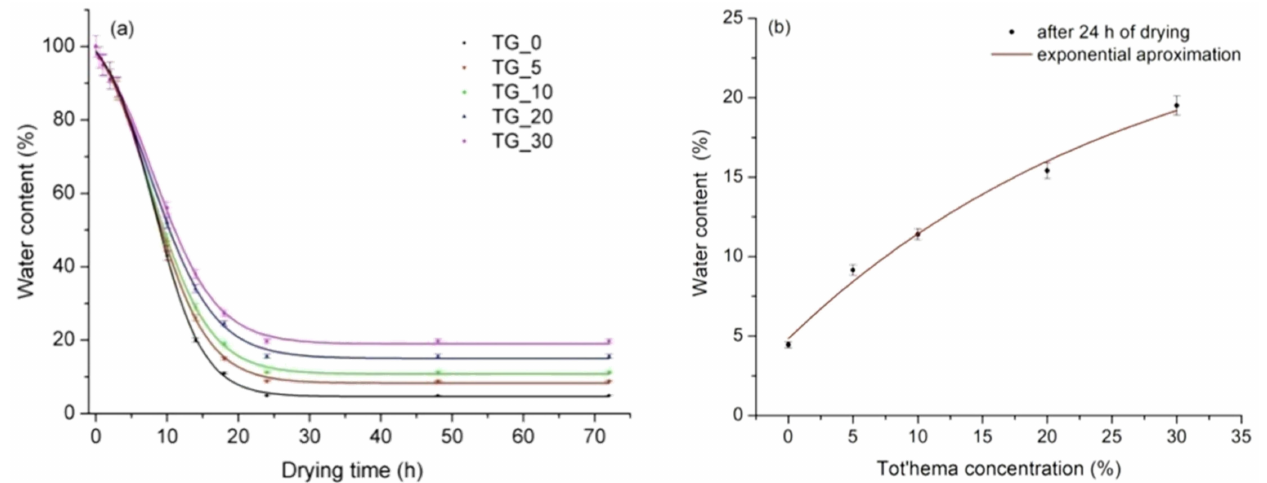
Figure 5. ( a ) Influence of drying time on the water content of TG_X films (X − 0, 5, 10, 20, and 30% of tot’hema); ( b ) The equilibrium water content as a function of tot’hema concentration.